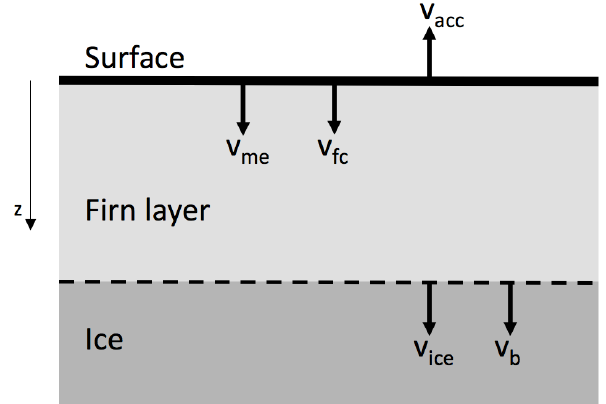
Fig. 1: Schematic representation of the firn layer (including surface snow) and the velocity components contributing to surface elevation changes: accumulation ( v acc ), melt ( v me ), firn compaction ( v fc ), downward ice flow ( v ice ) and bedrock movement ( v b ), adjusted from Zwally and Li